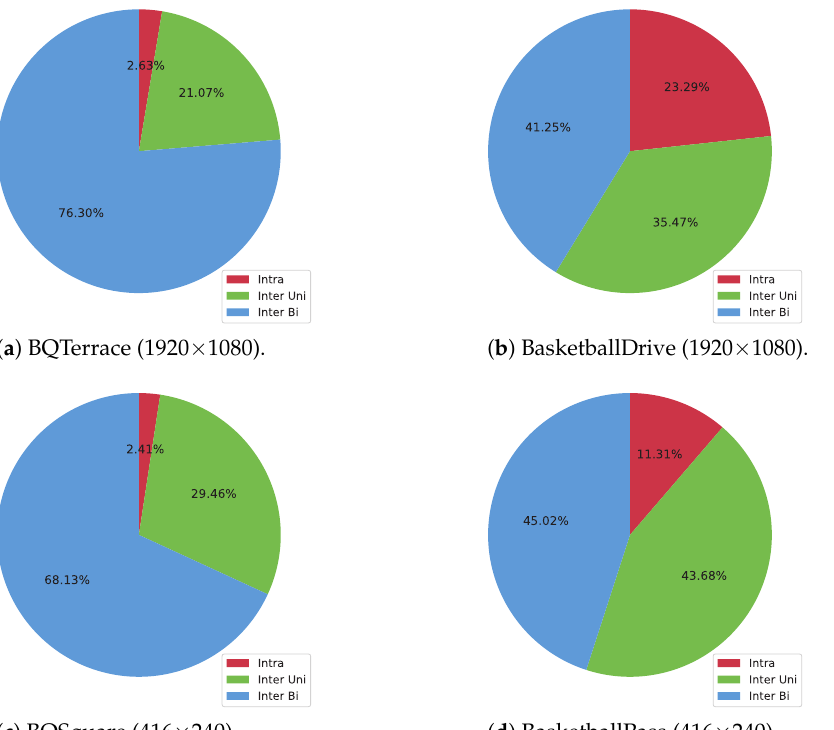
Figure 1. The ratio of number of CUs for selected modes with the first 2 s results under random access (RA) and